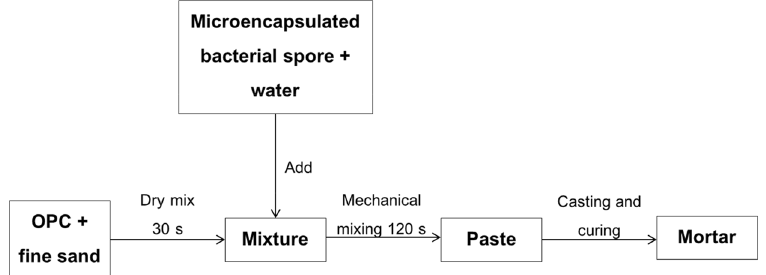
Figure 1. Preparation of the mortar with microencapsulated bacterial spores. OPC = ordinary Portland cement type